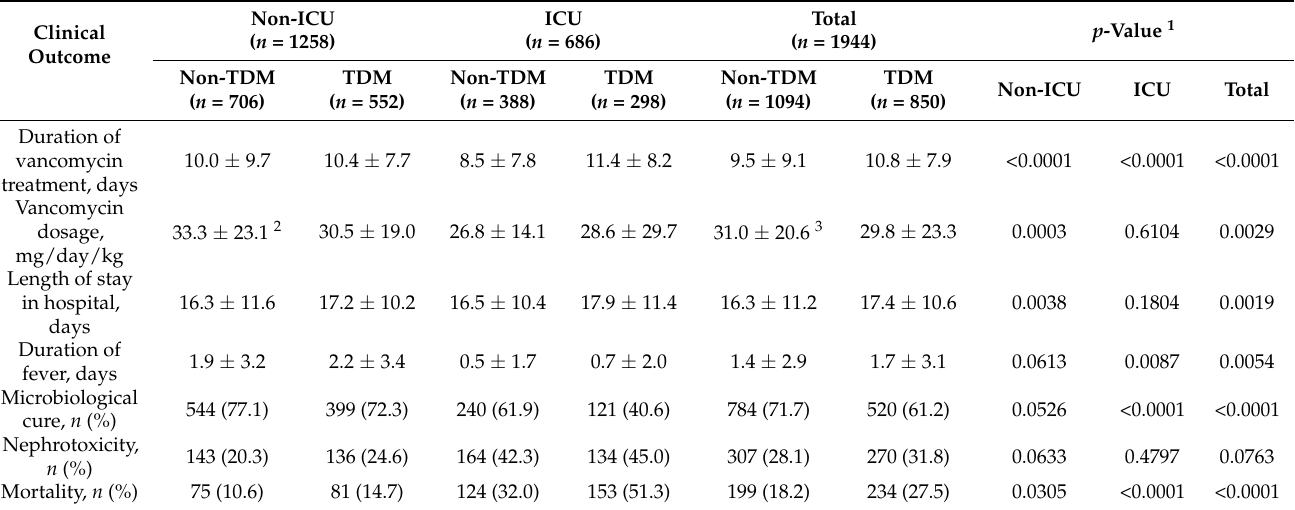
Table 2. Clinical outcomes by ICU admission and TDM group: univariate